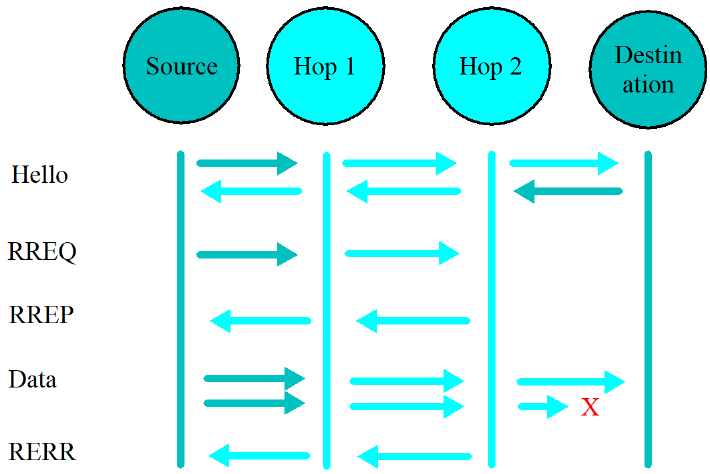
Figure 1. AODV messaging.